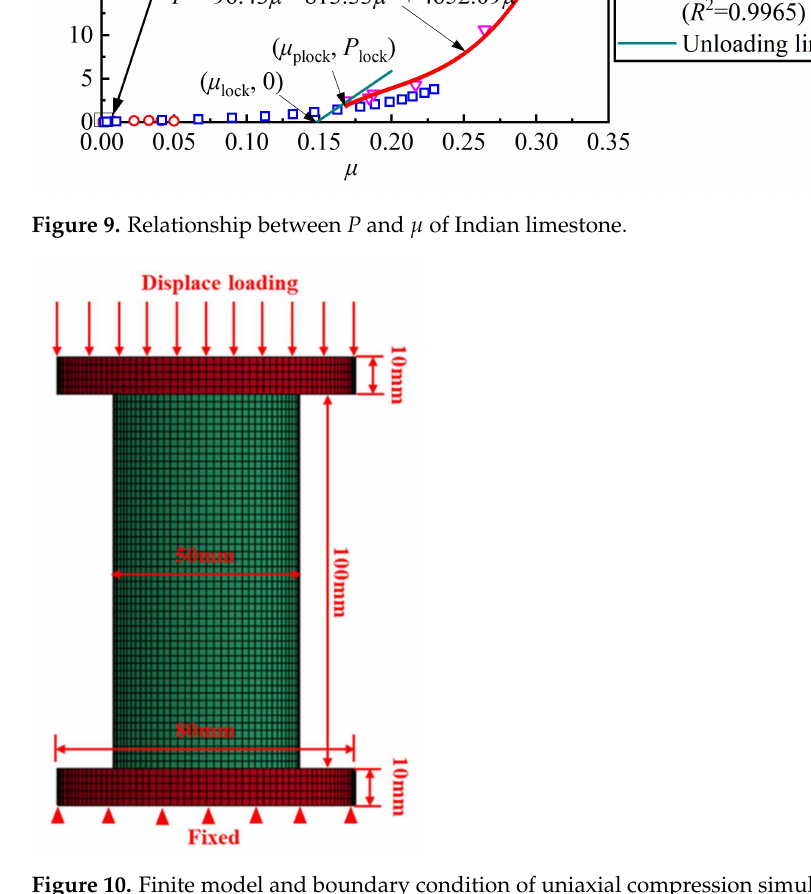
Figure 10. Finite model and boundary condition of uniaxial compression